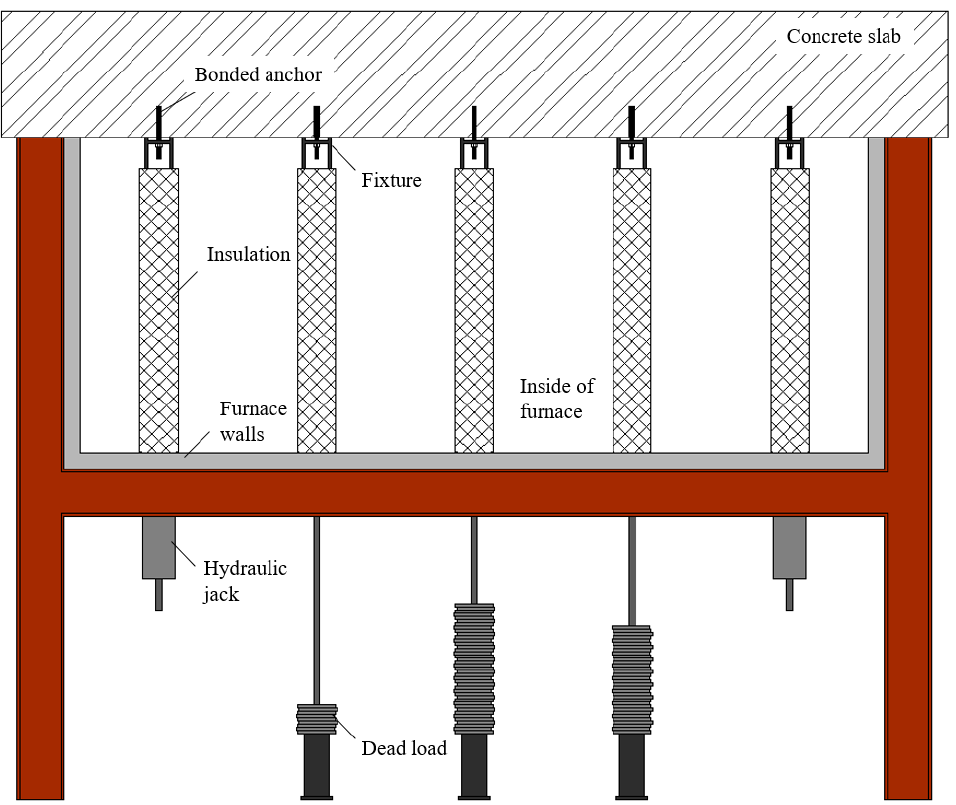
Figure 1. TU Kaiserslautern’s furnace and loading system for fire tests on bonded anchors [20].